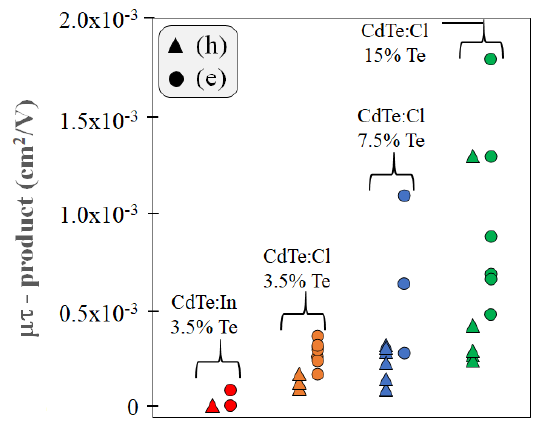
Figure 19. A summary of µτ products for holes and electrons in relation with Te-secondary phases, showing roughly a linear relationship with the averaged µτ values.